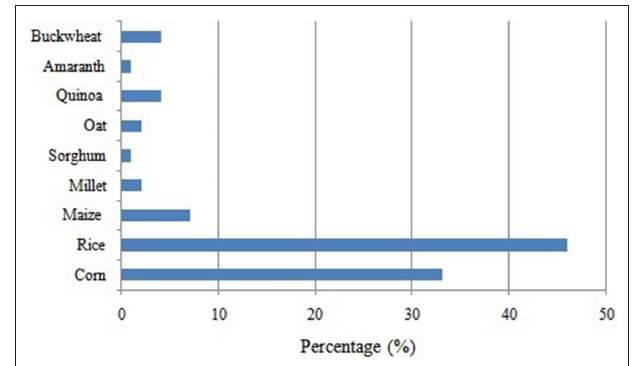
FIGURE 1 | Principal grains used for gluten-free products on the market [adapted from